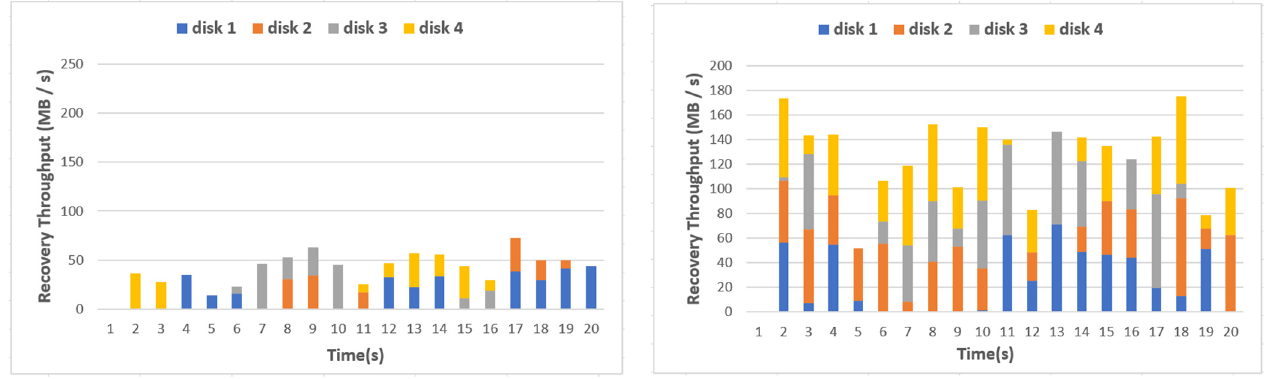
Figure 23. Disk usage of the EC HDFS ( left ) and the EC HDFS-LR ( right ).